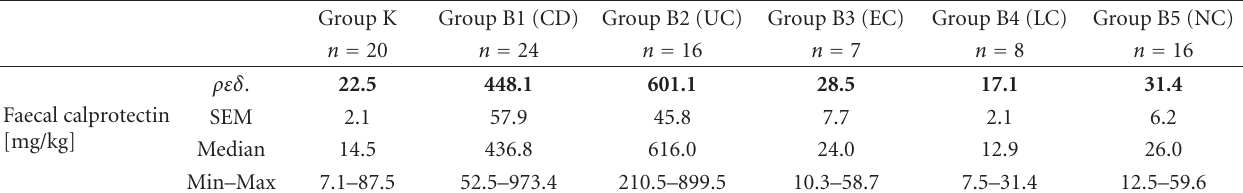
Table 1: Faecal calprotectin concentrations in the study